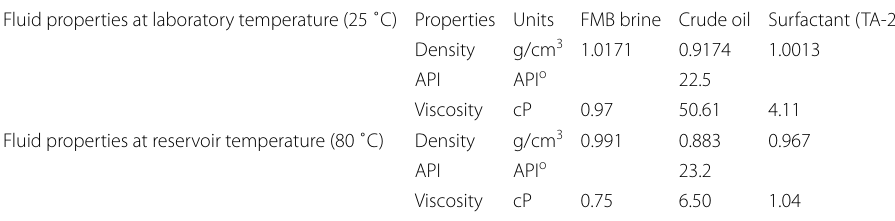
Table 5 Fluid properties at laboratory and reservoir temperatures